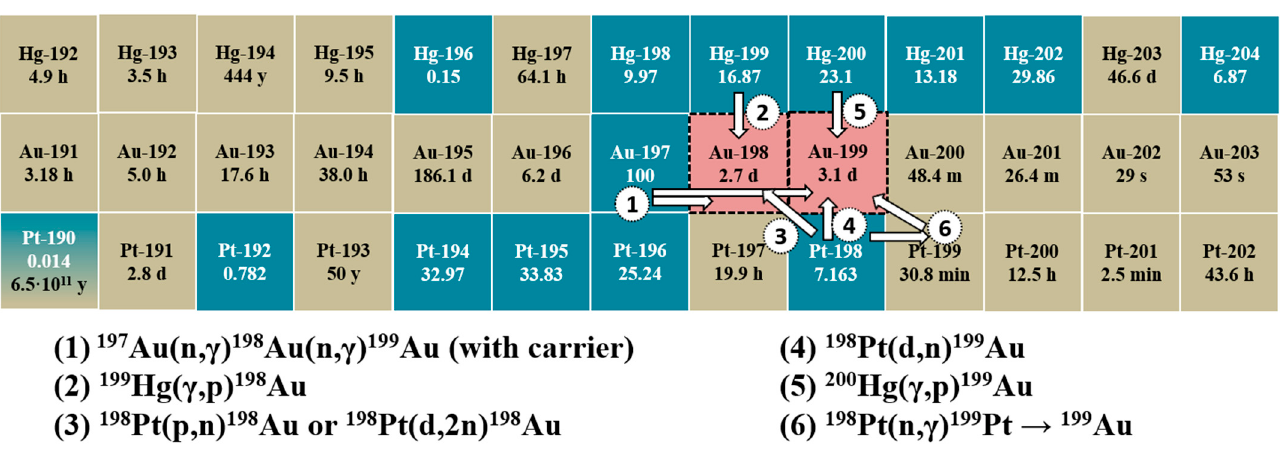
Figure 1. Studied ways of obtaining 198,199 Au on a fragment of a nuclide chart. Aquamarine cells contain stable nuclei with their content in the natural mixture; sand cells contain unstable nuclei with their T 1/2 (metastable nuclei are omitted).